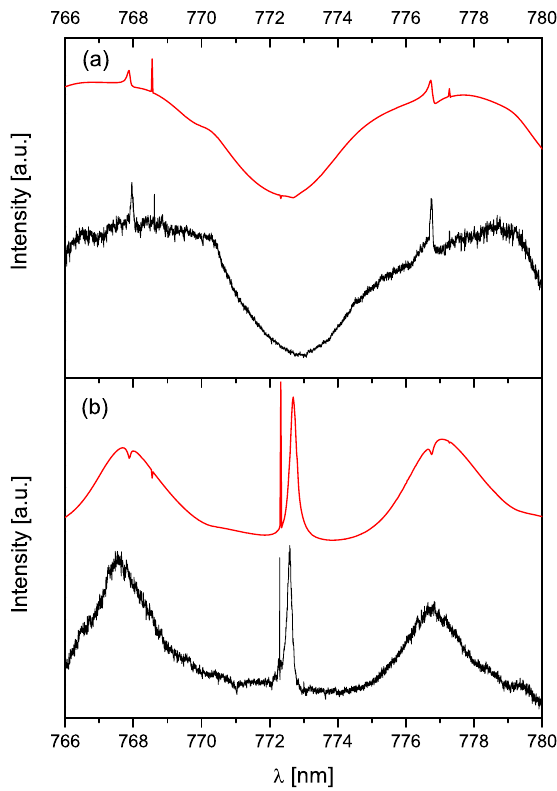
Figure 1. (a) TE and (b) TM spectra of shikimic acid particle under dry conditions at room temperature. Black line: experimental data. Red line: Mie calculation for a homogeneous particle with radius 7.756µm and refractive index of